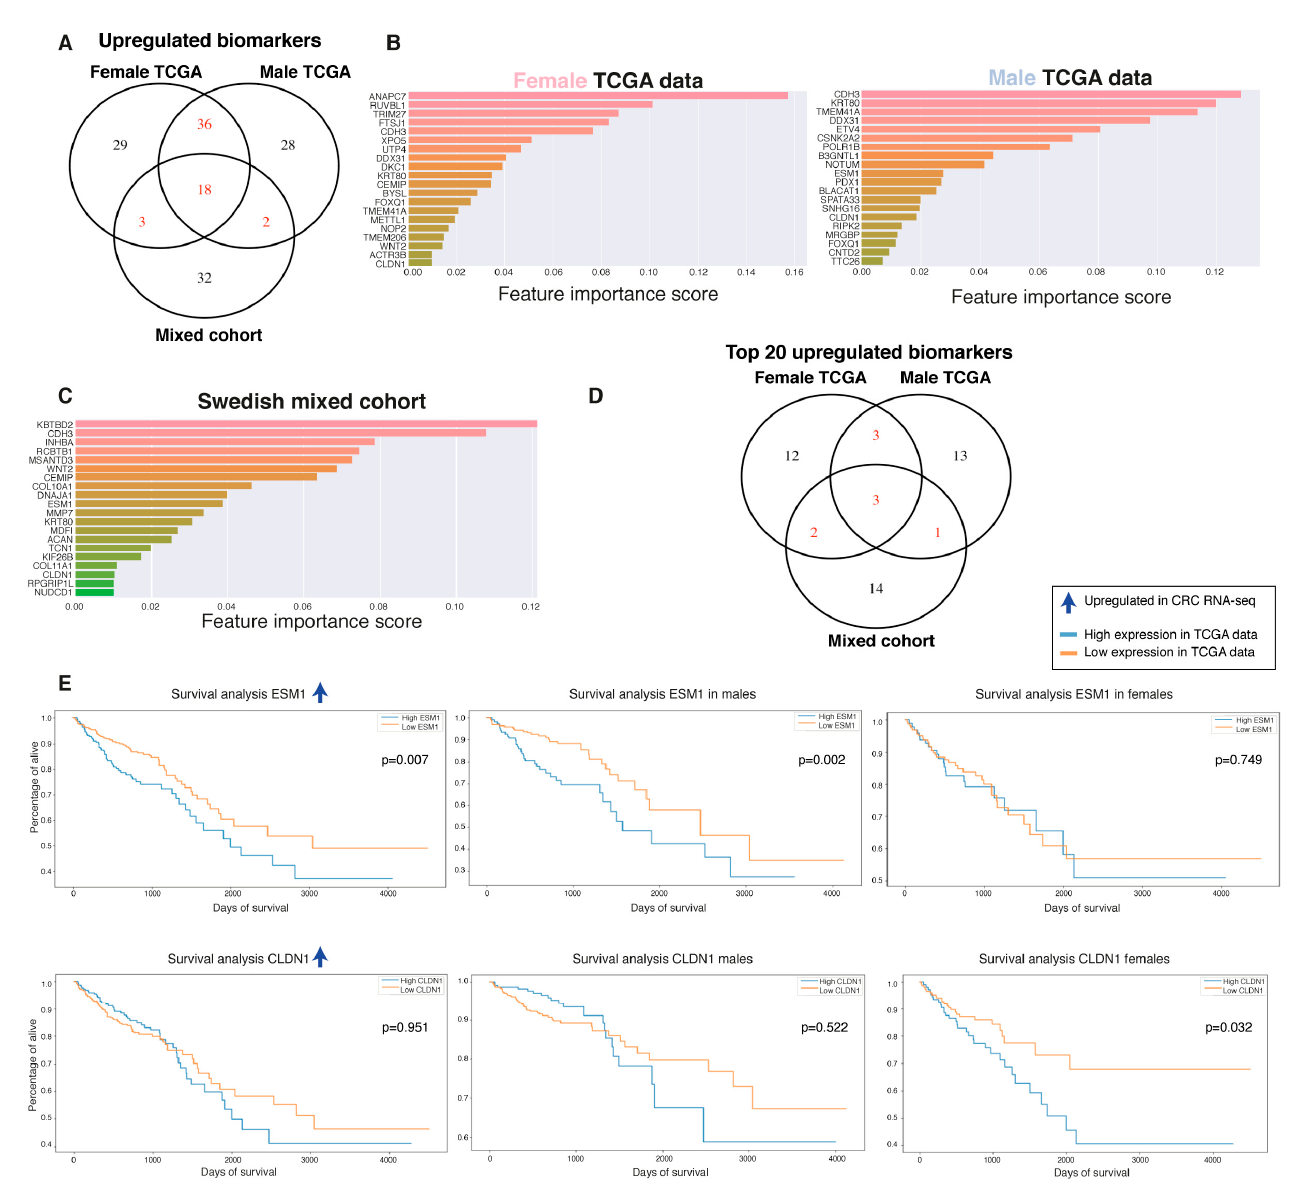
Figure 5. The top-ranked upregulated biomarkers ESM1 and CLDN1 presented a sex-specific unfavorable prognostic value. ( A ) Venn diagram illustrating the overlap of upregulated biomarkers identified with Boruta, specifically on the upregulated genes in female and male TCGA data and the Swedish mixed cohort. ( B ) The 20 top upregulated biomarkers ranked with ML using RF for female TCGA data, ( C ) male TCGA data, and ( D ) Swedish mixed cohort. ( E ) Venn diagram illustrating the overlap of the 20 top upregulated biomarkers in female and male TCGA data and the Swedish mixed cohort. ( E ) Survival analysis based on sex on TCGA data for the top-20 ranked features that significantly predicted OS.